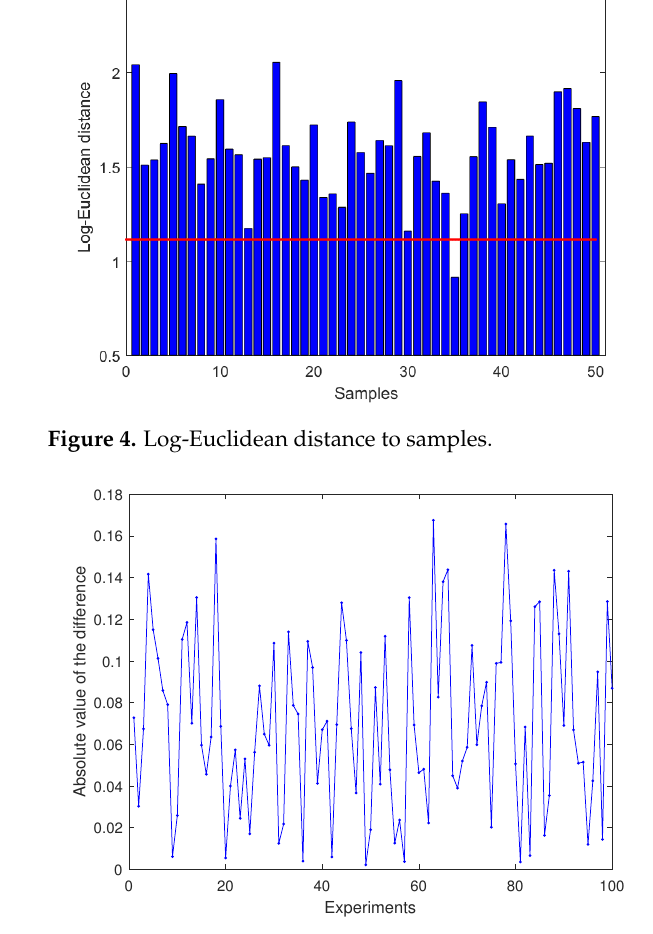
Figure 5. Absolute value of the difference gotten by two